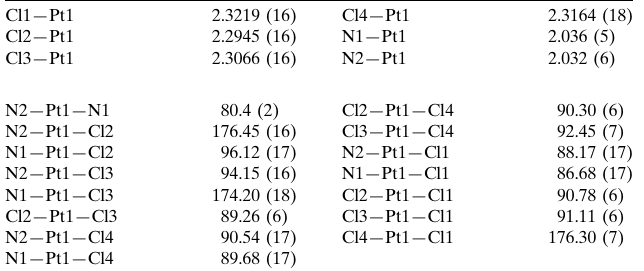
Selected geometric parameters (A˚ , (cid:4) ).